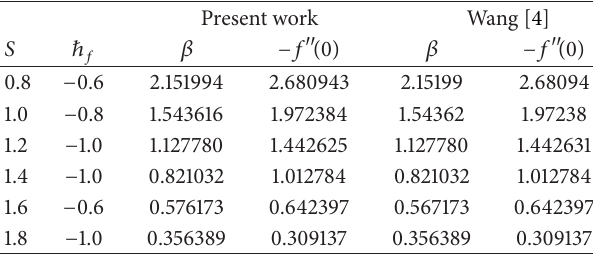
Table 1: Variations of the dimensionless film thickness 𝛽 = 𝛾 1/2 and the skin friction −𝑓 󸀠󸀠 (0) with respect to the unsteadiness parameter when Pr = 1 and 𝐾 = 0 using 10th-order HAM